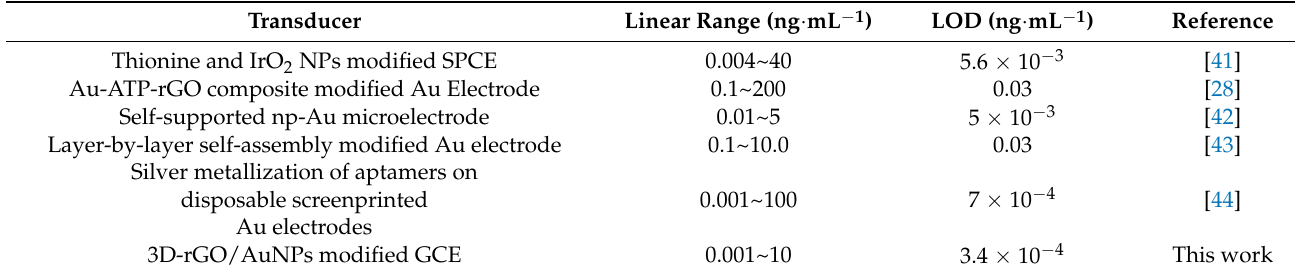
Table 1. Comparison of the developed impedimetric aptasensors for OTA detection.